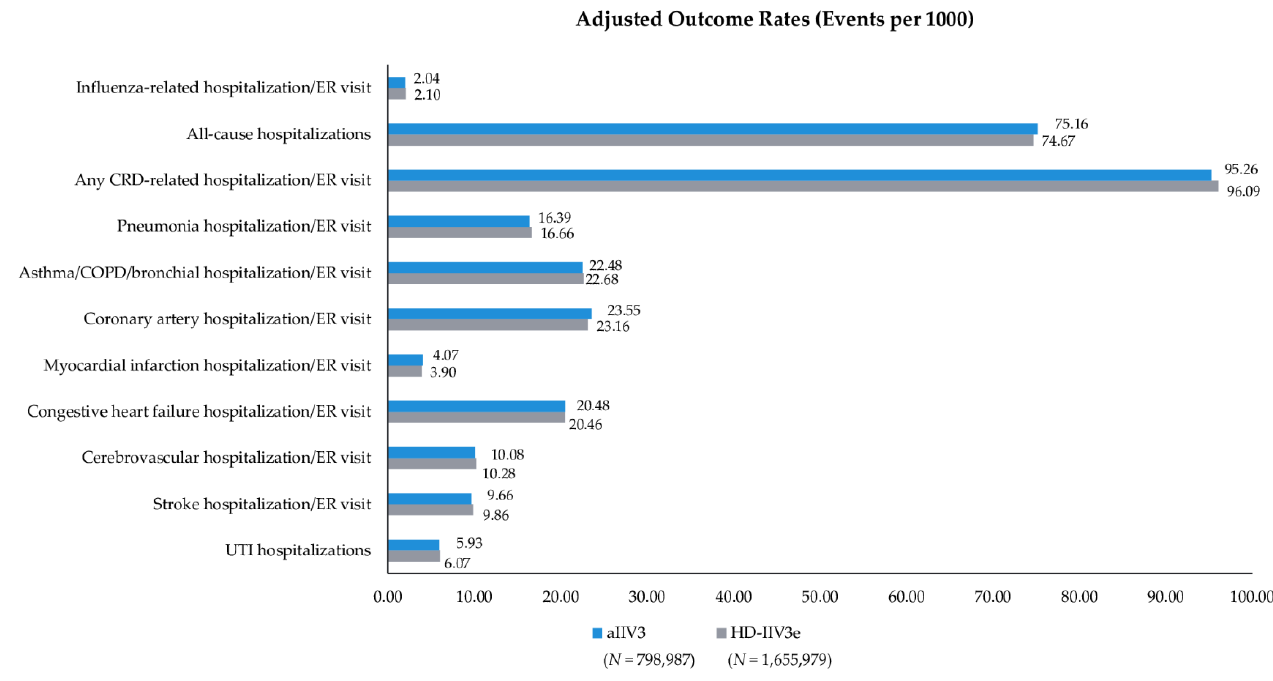
Figure 2. Adjusted Outcome Rates—Post-IPTW—aIIV3 vs. HD-IIV3e. Rate = events per 1000 vaccinated patients; aIIV3 = adjuvanted trivalent influenza vaccine; CRD = cardio-respiratory disease; ER = emergency room; HD-IIV3e = high-dose trivalent influenza vaccine; UTI = urinary tract infection.